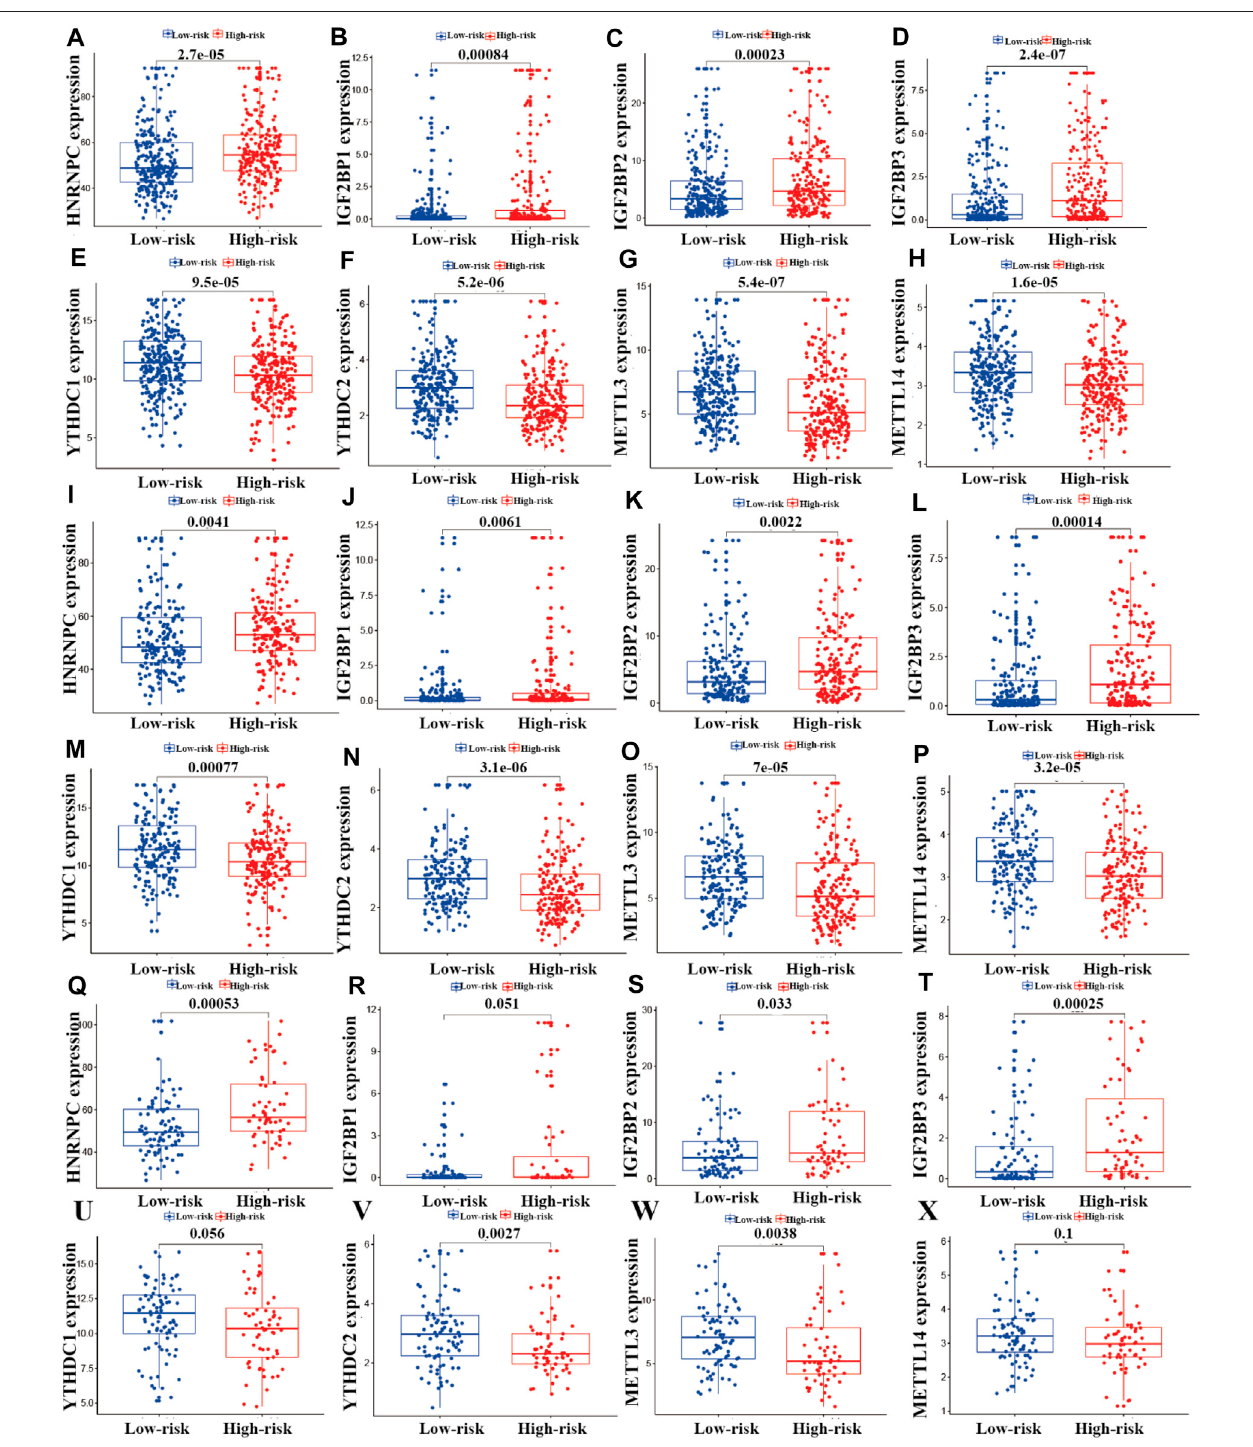
FIGURE9 | Correlationanalysisof m 6 Aregulators and the prognostic riskmodel. (A – X) Differential analysisofm 6 Aregulators inthe prognostic model for thehigh- and low-risk cohorts.